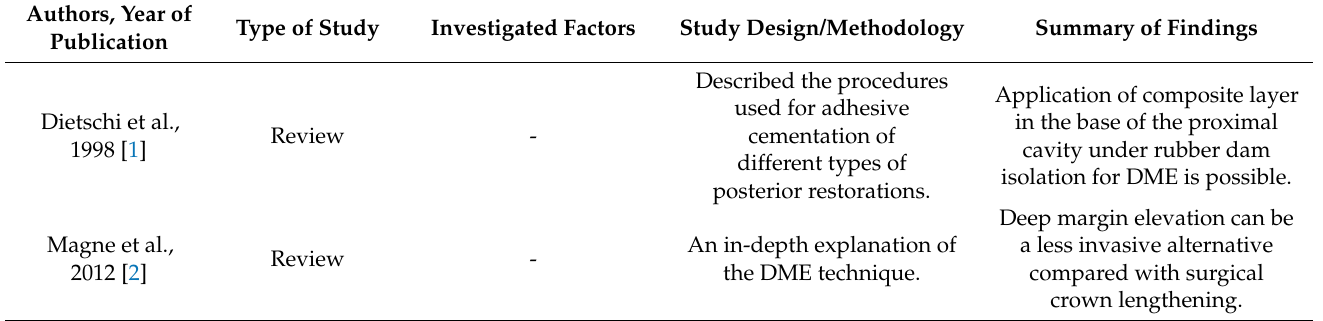
Table 1. Summary of reviewed studies.